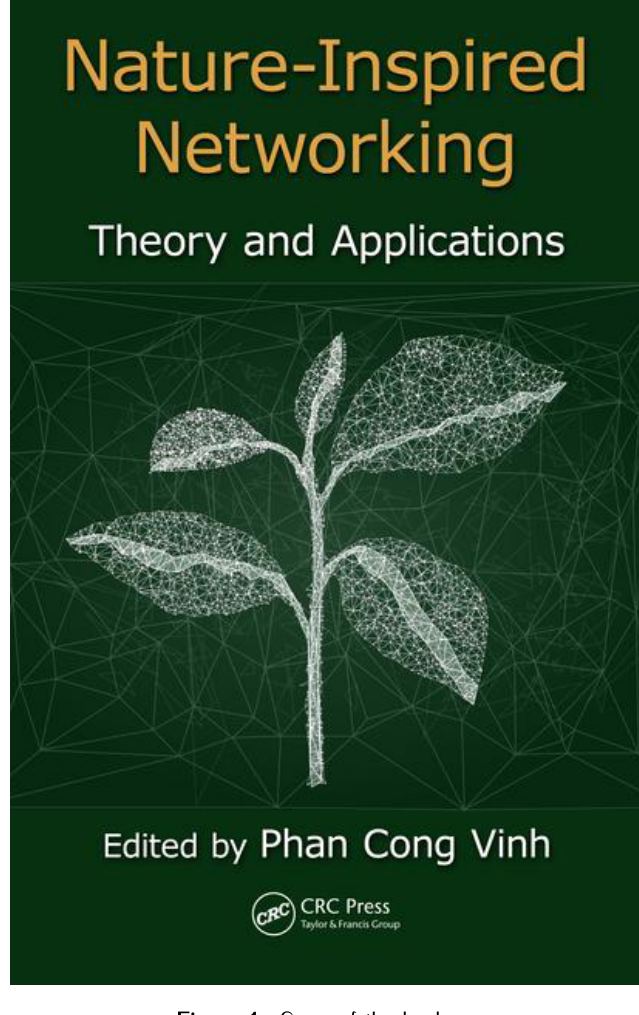
Figure 1. Cover of the